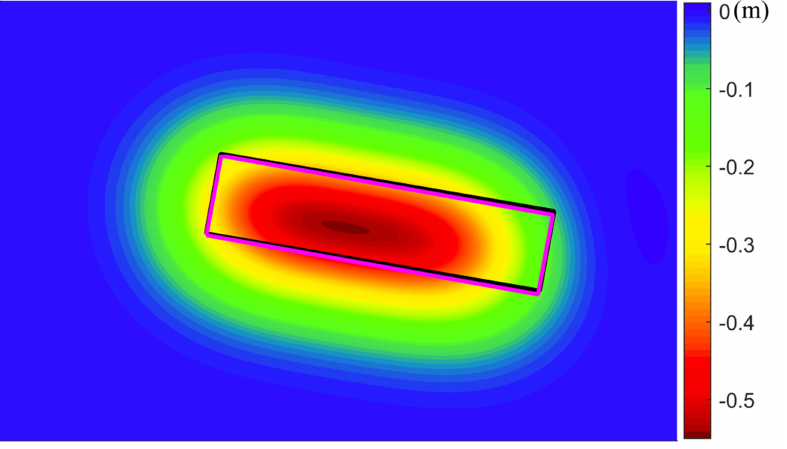
Figure 4. The simulated LOS deformation. The black and purple polygons represent the simulated goaf and the location result of the goaf,